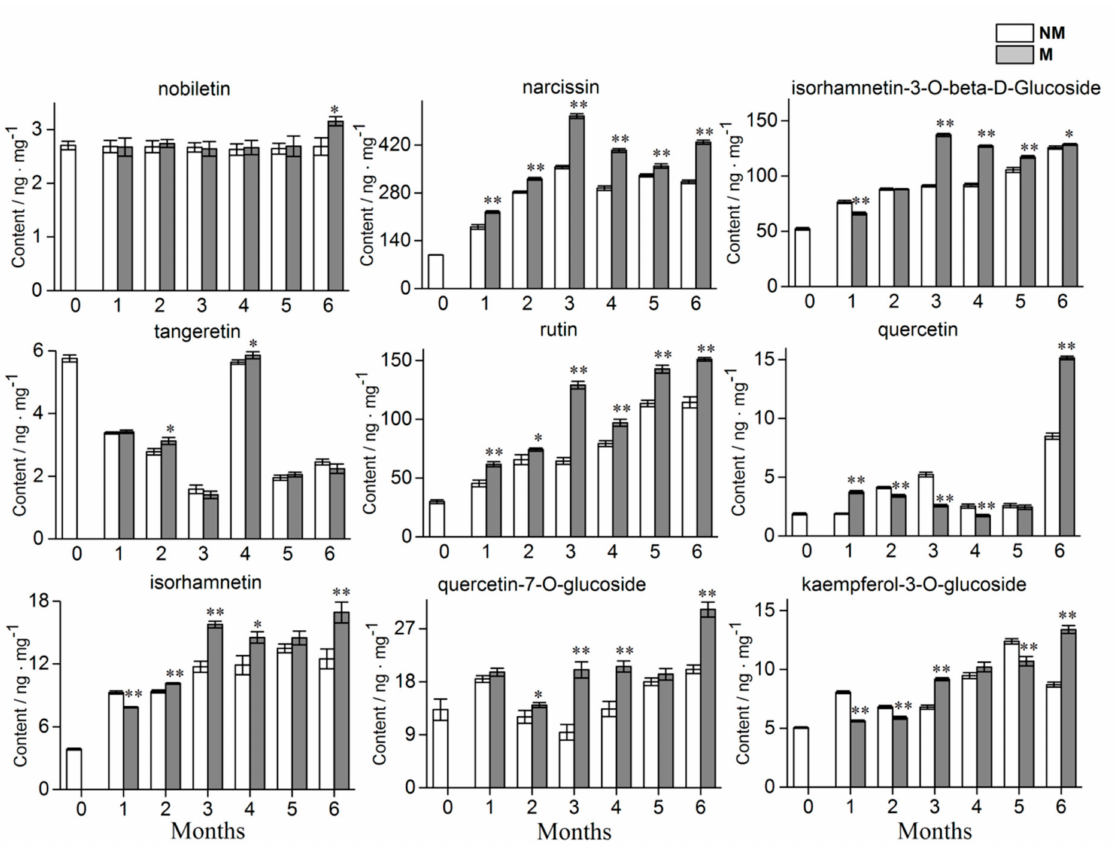
Figure 7. Dynamic variations of 9 flavonoids in the mycorrhizal and non-mycorrhizal A. roxburghii growth 0 month to 6 months. NM and M represents non-mycorrhizal A. roxburghii and mycorrhizal A. roxburghii , respectively. Each value is the mean of three replicates, and error bars indicate standard deviations. Statistical analysis of the data was performed by independent samples t -test using the SPSS 22.0 software (IBM, Chicago, IL, USA). * and ** above the columns are significantly di ff erent at p ≤ 0.05 and p ≤ 0.01,